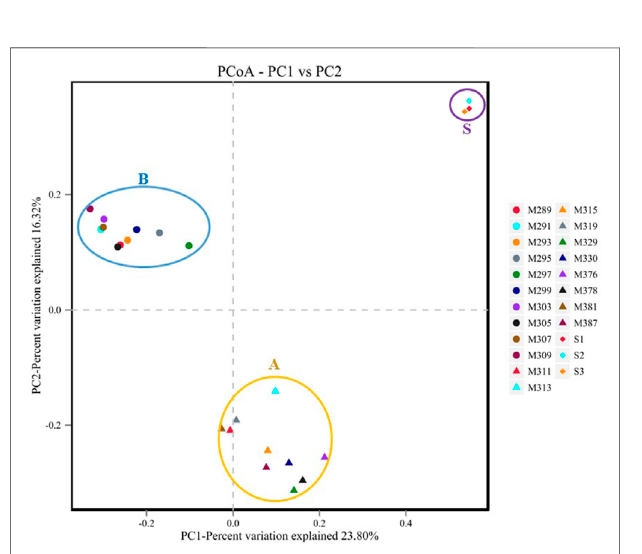
FIGURE 5 | Bacterial community complexity was evaluated using the alphacomponentsincludingthespeciesrichness(ACEandChao1index)and diversity (Simpson and Shannon index) in all sedimentary